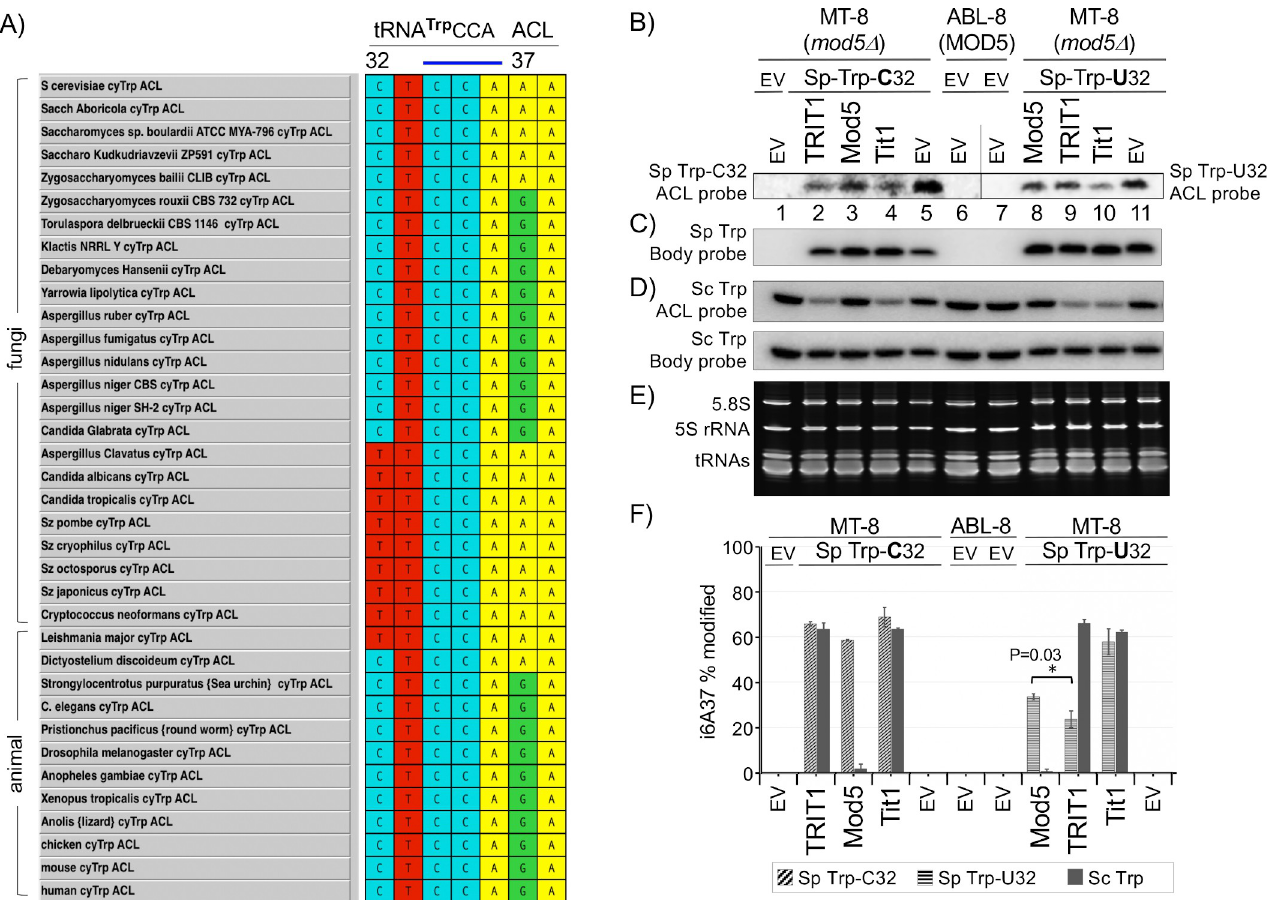
Fig 7. Position 32 as a determinant of differential IPTase activity for cy-tRNA Trp CCA in eukaryotes. A) Sequence alignment of the cy-tRNA Trp CCA ACLs in the eukaryotes indicated; the 32 and 37 positions are numbered above; a horizontal blue bar indicates the AC. B) Results of PHA6 i 6 A37-sensitive PHA6 northern blot after expressing a S . pombe cy-tRNA Trp CCA gene in MT-8 ( mod5 Δ ) S . cerevisiae containing the native U32 (right panel) or this position mutated to C32 (left panel), or empty vector (EV) as indicated above the lanes, in the presence the IPTases or empty vector (EV) also indicated above the lanes; ABL-8 is a MOD5 positive strain. The right and left panel blots show separate hybridizations with ACL probes. Note that the order of the IPTases in the left and right panels differs, and carries through to panel F. C) The body probe result for S . pombe cy-tRNA Trp CCA. D) ACL probe (upper) and body probe (lower) results for endogenous S . cerevisiae cy-tRNA Trp CCA as indicated. E) shows the EtBr-stained gel from which the blot was made. F) Quantification of % i 6 A37 modification of the three different cy-tRNAs Trp CCA as indicated; error bars indicate standard deviation (SD) from biological duplicates. P value was obtained by the paired t-